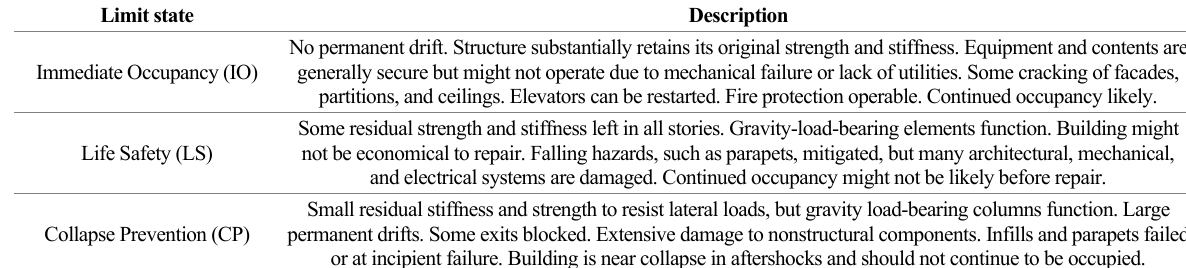
Table 2. Qualitative description of the limit states. Limit state